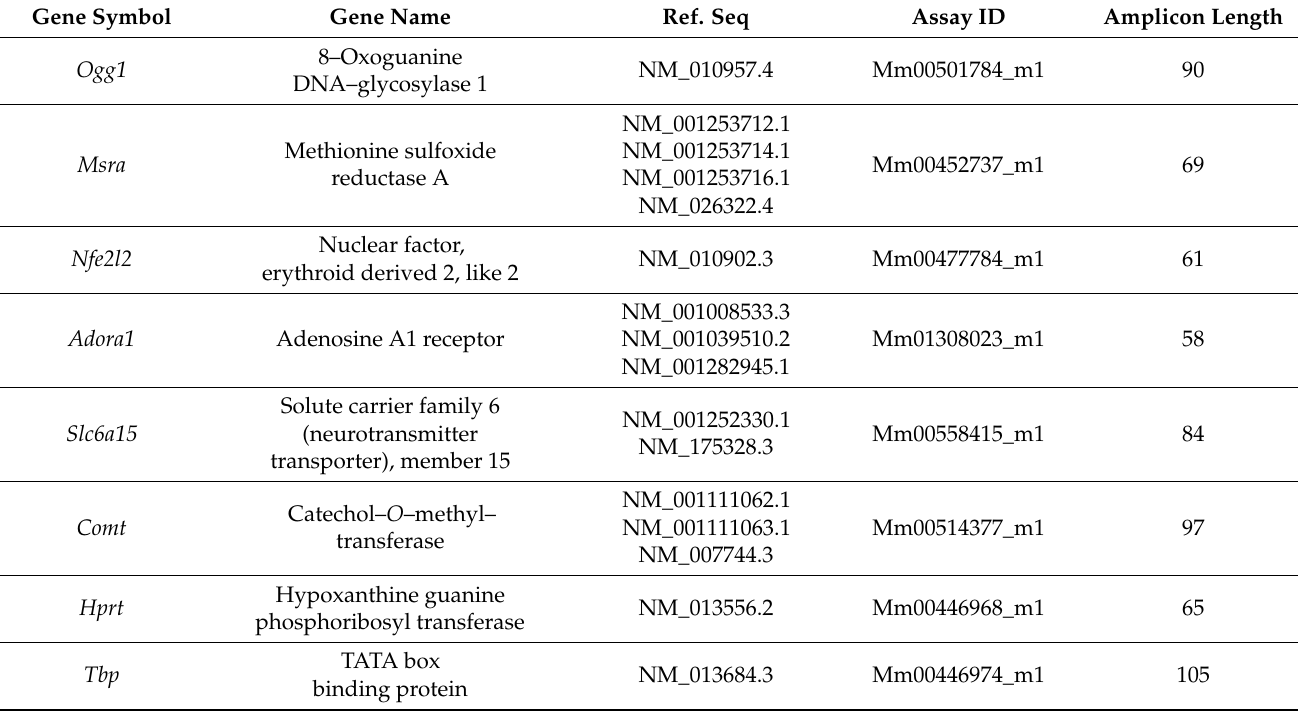
Table 2. Gene symbols, gene names, GenBank reference sequence accession numbers, assay IDs and amplicon lengths (bp). Gene